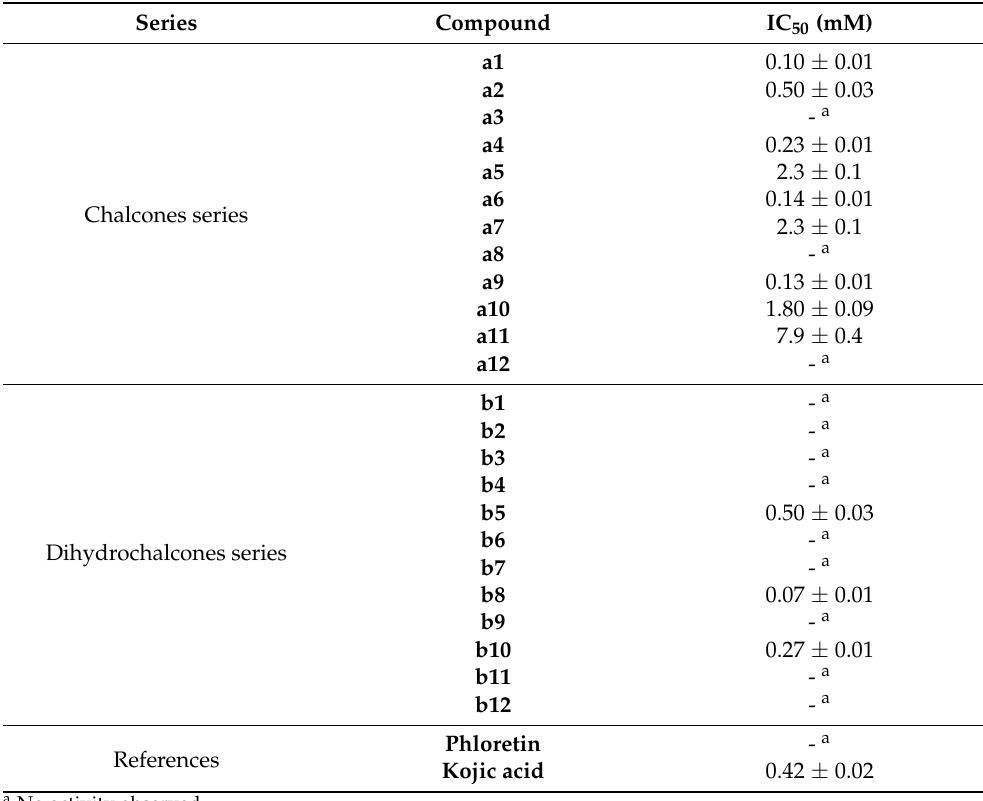
Table 1. IC 50 of synthesized compounds for mushroom tyrosinase